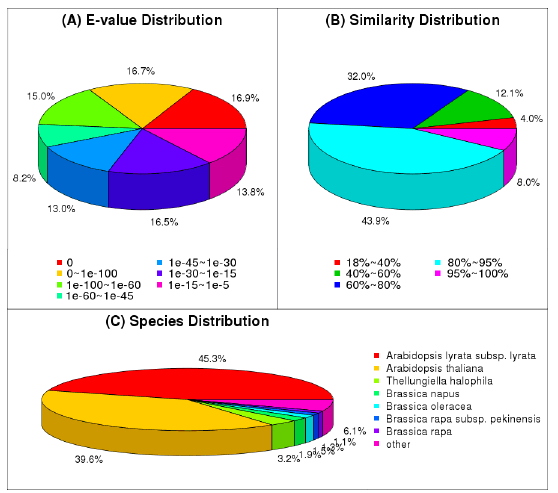
Figure 4. Statistics of homology search of unigenes against nr peptide database. A) E-value distribution of the top BLASTx hits with a cut-off E-value of 1e-05. B) Similarity distribution of the top BLASTx hits with a cut-off E-value of 1e-05. C) Species distribution of the top BLASTx hits is shown as a percentage of the total homologous sequences with an E-value greater than or equal to 1e-05.